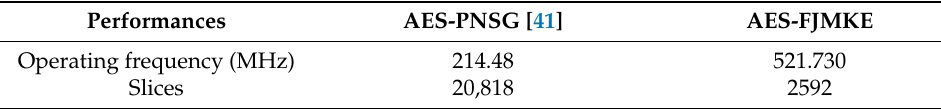
Table 9. Evaluation of AES-FJMKE and AES-AT for Virtex 5.